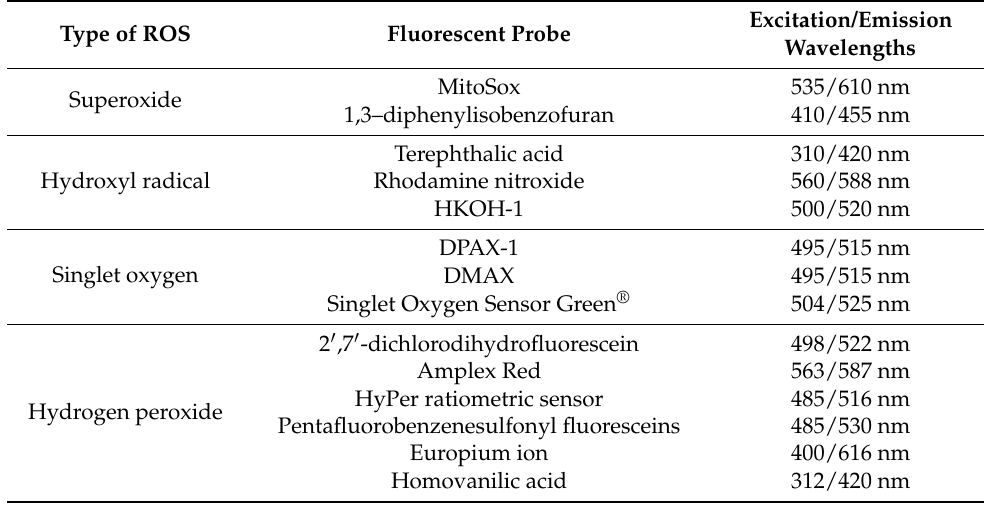
Table 2. Overview of fluorescent probes for the detection of ROS [79,95,97,98,114,115,137,141–143,145].